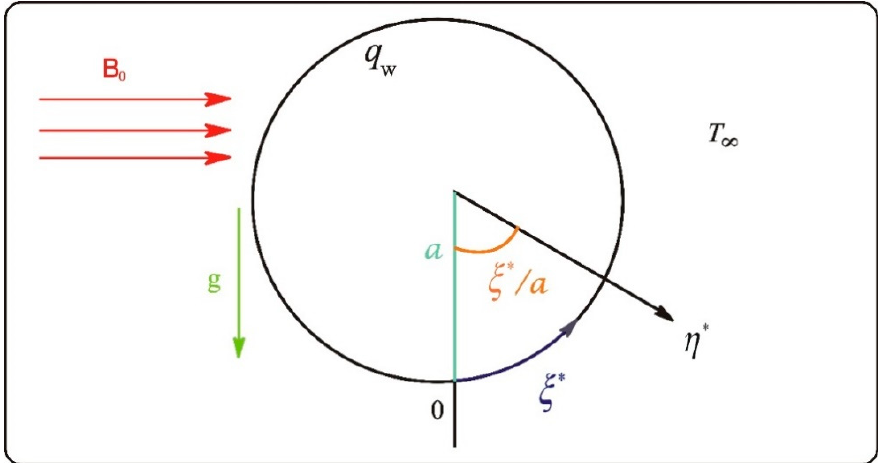
Figure 1. Schematic diagram of the problem.